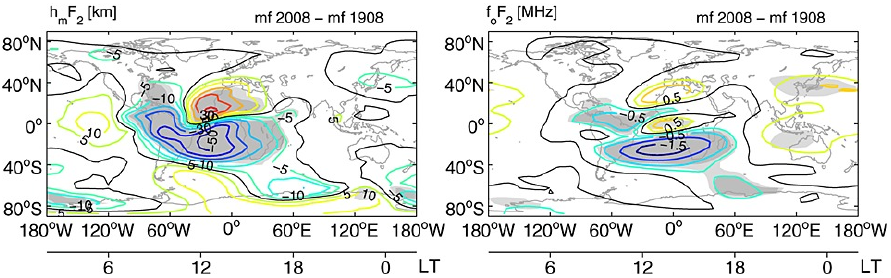
Figure 7. Maps showing the difference of the 15 ‐ day mean hmF2 ( left ) and foF2 ( right ) in 2008 with 1908 at 14:00 UT. Light (dark) shading indicates 95% (99%) statistical significance. (Reproduced from Cnossen and Richmond [81]: Figure 3, modified).